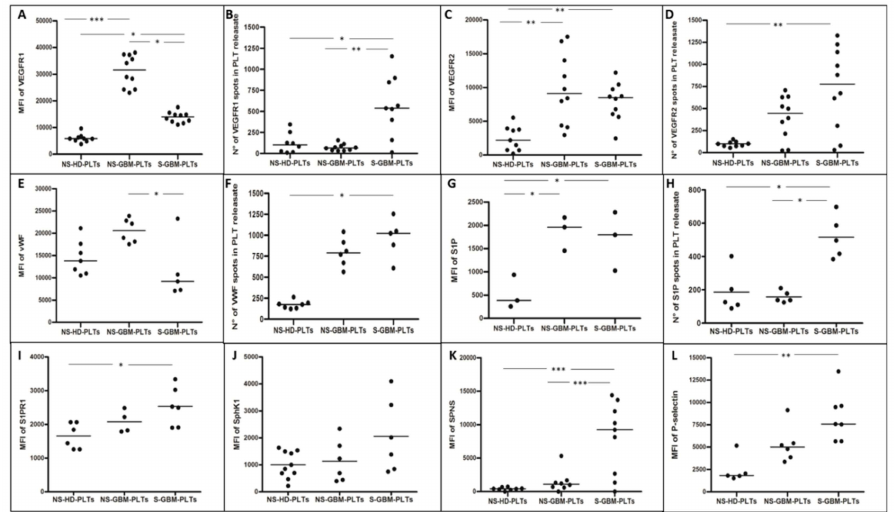
Figure 3. GBM-PLTs expressed and released pro-angiogenic and pro-tumoral molecules compared to HD-PLTs. Data from ( A )VEGFR1, ( C )VEGFR2, ( E ) VWF, ( G ) S1P, ( I ) S1PR1, ( J ) SPhK1, ( K ) SPNS, and ( L ) P-selectin labelings of PLTs from HD and GBM patients in non-stimulated (NS-) and stimulated (S-) conditions. Image analysis through ad-hoc-created pipeline of binary segmentation and object quantification to detect and analyze the specific mean fluorescence intensity (MFI) of PLTs in an 18-mm 2 field of view (FOV). The number of spots of ( B ) VEGFR1, ( D ) VEGFR2, ( F )VWF, and ( H ) S1P were detected and counted with the same pipeline of binary segmentation in the PLT-releasate. * p < 0.05, ** p < 0.01, *** p < 0.001 versus healthy donors